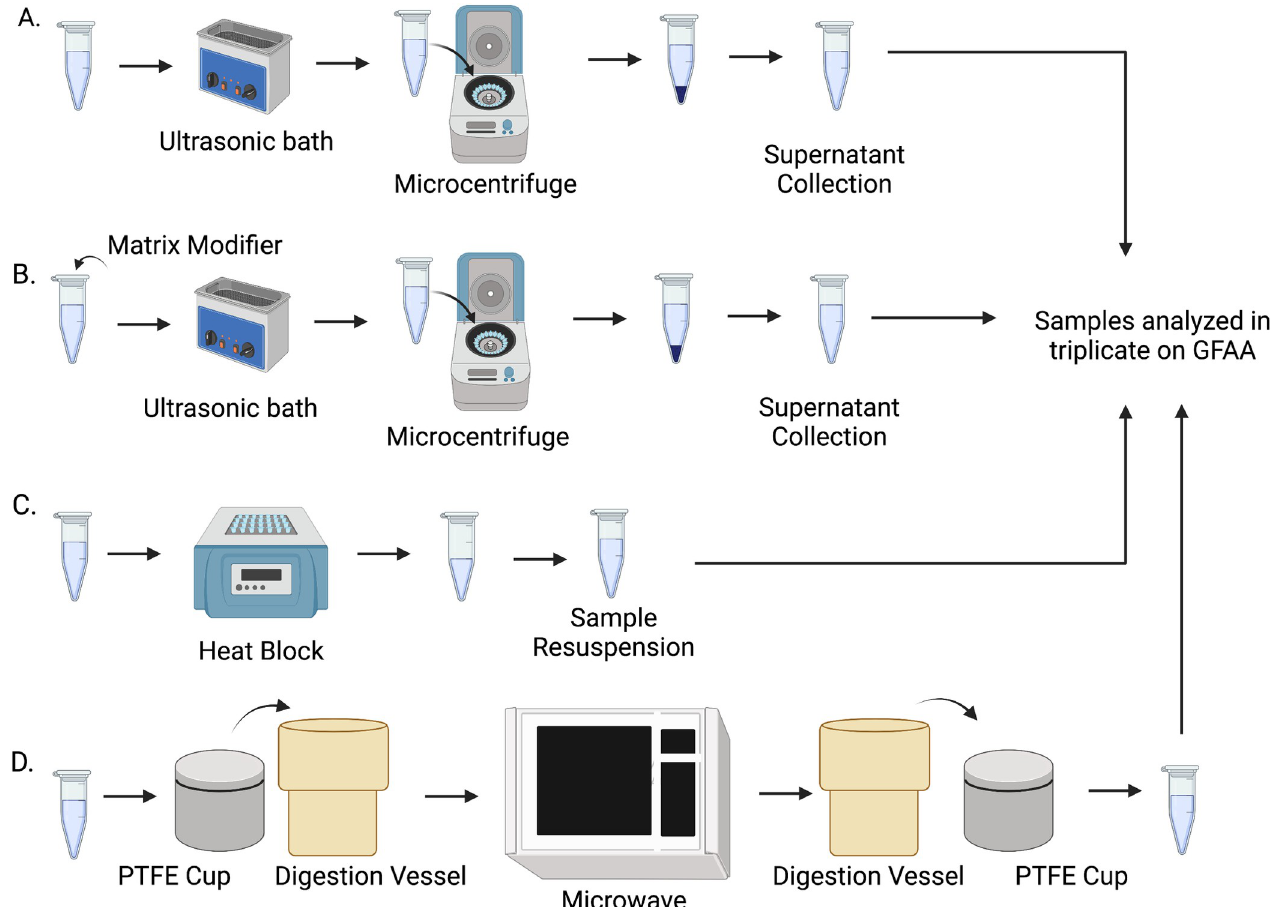
Fig 1. Flowchart of the four different sample preparation methodologies explored for the optimization of chemical process for the lead detection in biological materials A) Acidic dilution B) Addition of a matrix modifier C) Open-vessel acid digestion and D) Microwave assisted acid digestion.